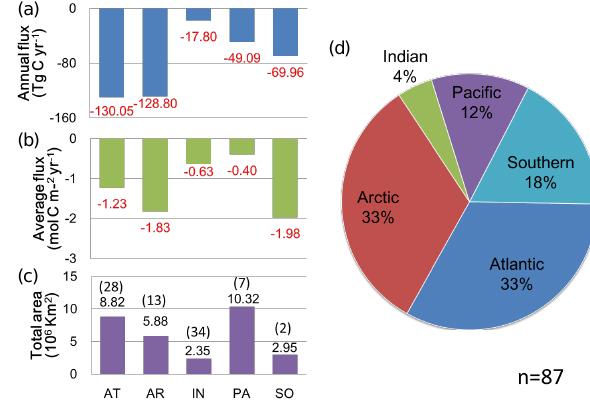
1 Figure 11. Annual CO 2 flux (a), average CO 2 flux per unit area (b), total surface area (c), and percentage of 2 Fig. 11. Annual CO 2 flux (a) , average CO 2 flux per unit area (b) , total CO 2 flux (d) from continental shelves in different continents. Numbers in parentheses 3 total surface area (c) , and percentage of total CO 2 flux (d) from indicate the number of estuaries studied. 4 continental shelves in different continents. Numbers in parentheses 5 indicate the number of estuaries studied.